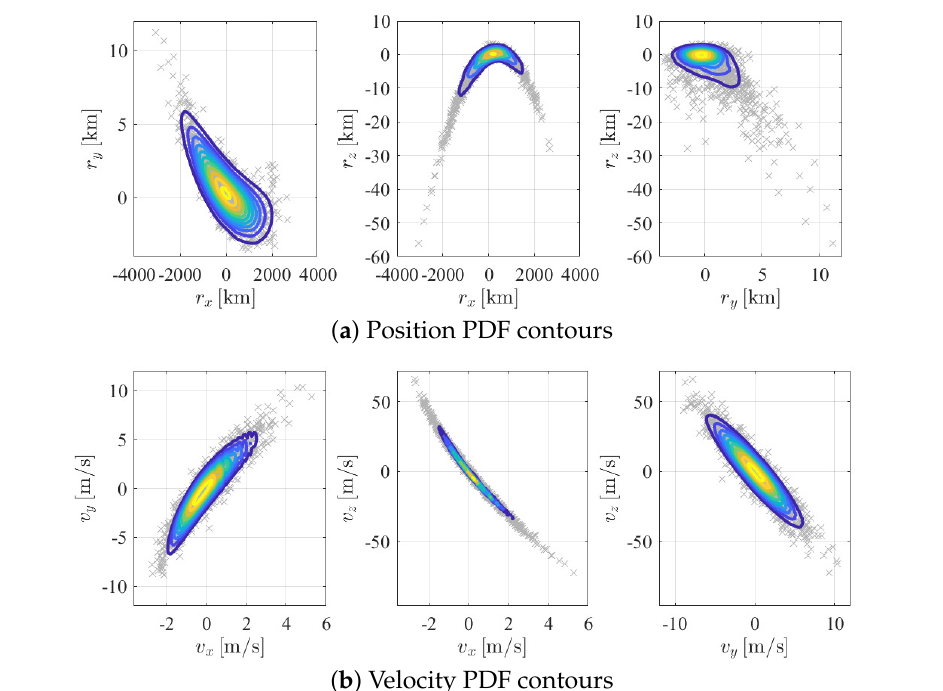
Figure 10. PDF contours using AGMM-VSG with Monte Carlo samples for TQO